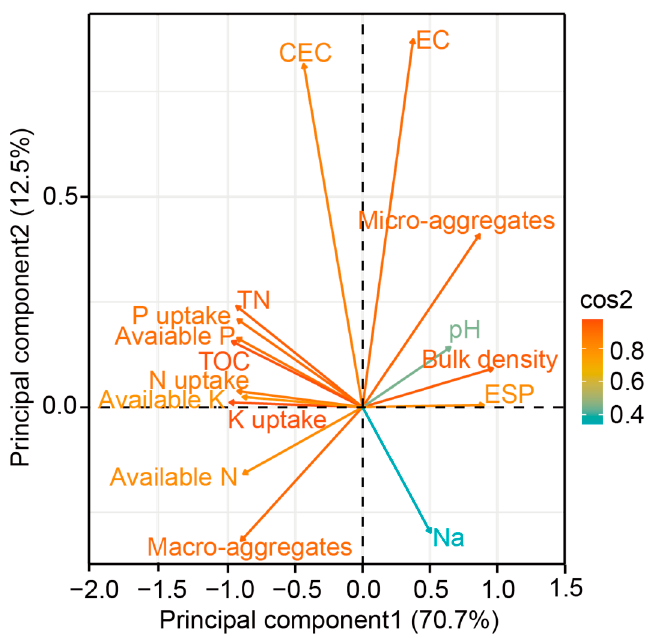
Figure 4. Principal component analysis (PCA) of nutrient uptake and soil properties in saline soil. Cos2 represents the quality of variations in the PCA, and a higher value of cos2 indicates a larger contribution of variation to the principal